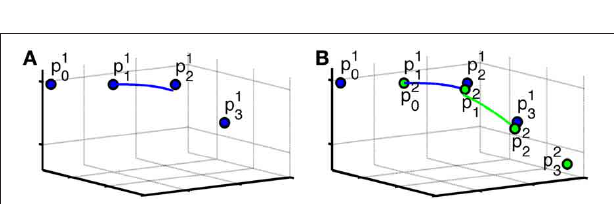
FIGURE 1 | (A) The diffusion phantom with fibers indicated with red tubes on top of the FA map. ROIs used to identify the fibers are indicated with a colored square and a number. (B) The ground truth fiber orientations in one voxel. (C) Sixty-four squares displaying the diffusion values from the diffusion